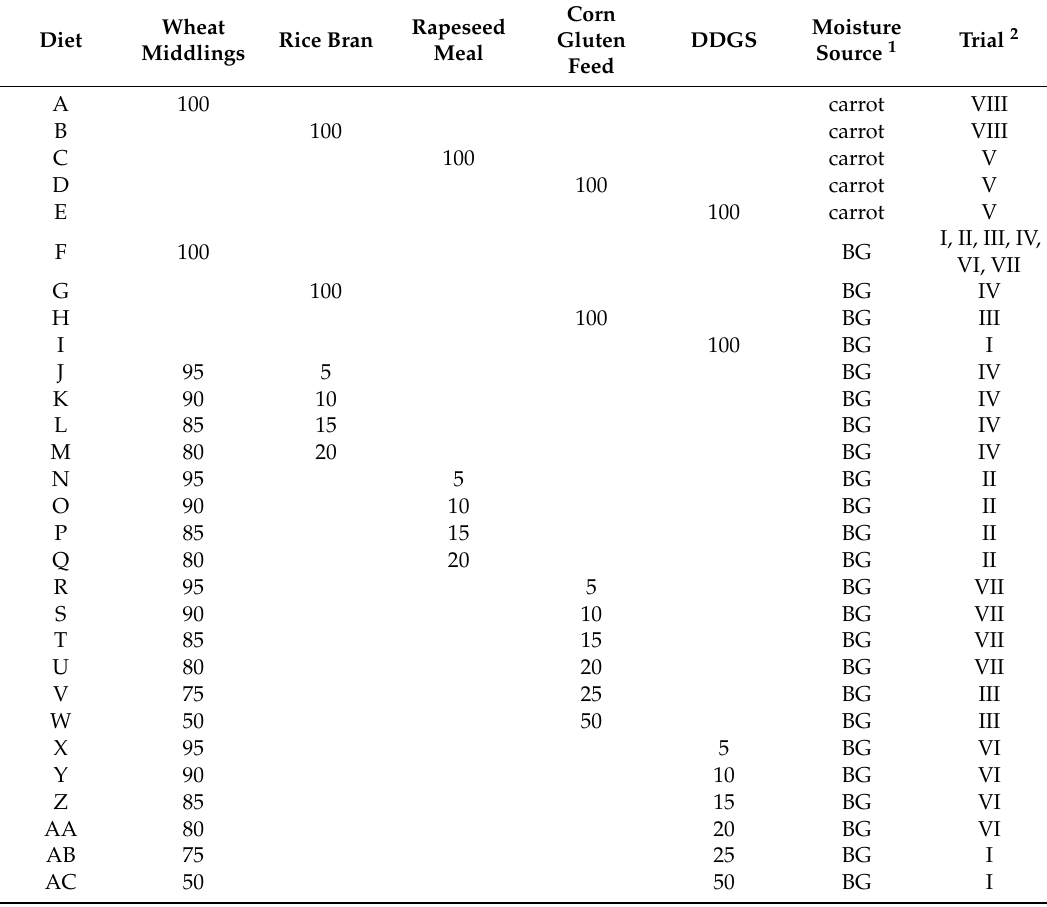
Table 2. Overview and inclusion percentages of the side-streams (expressed as fresh matter grams of side-stream per 100 g mixture) in the insect diets tested in this